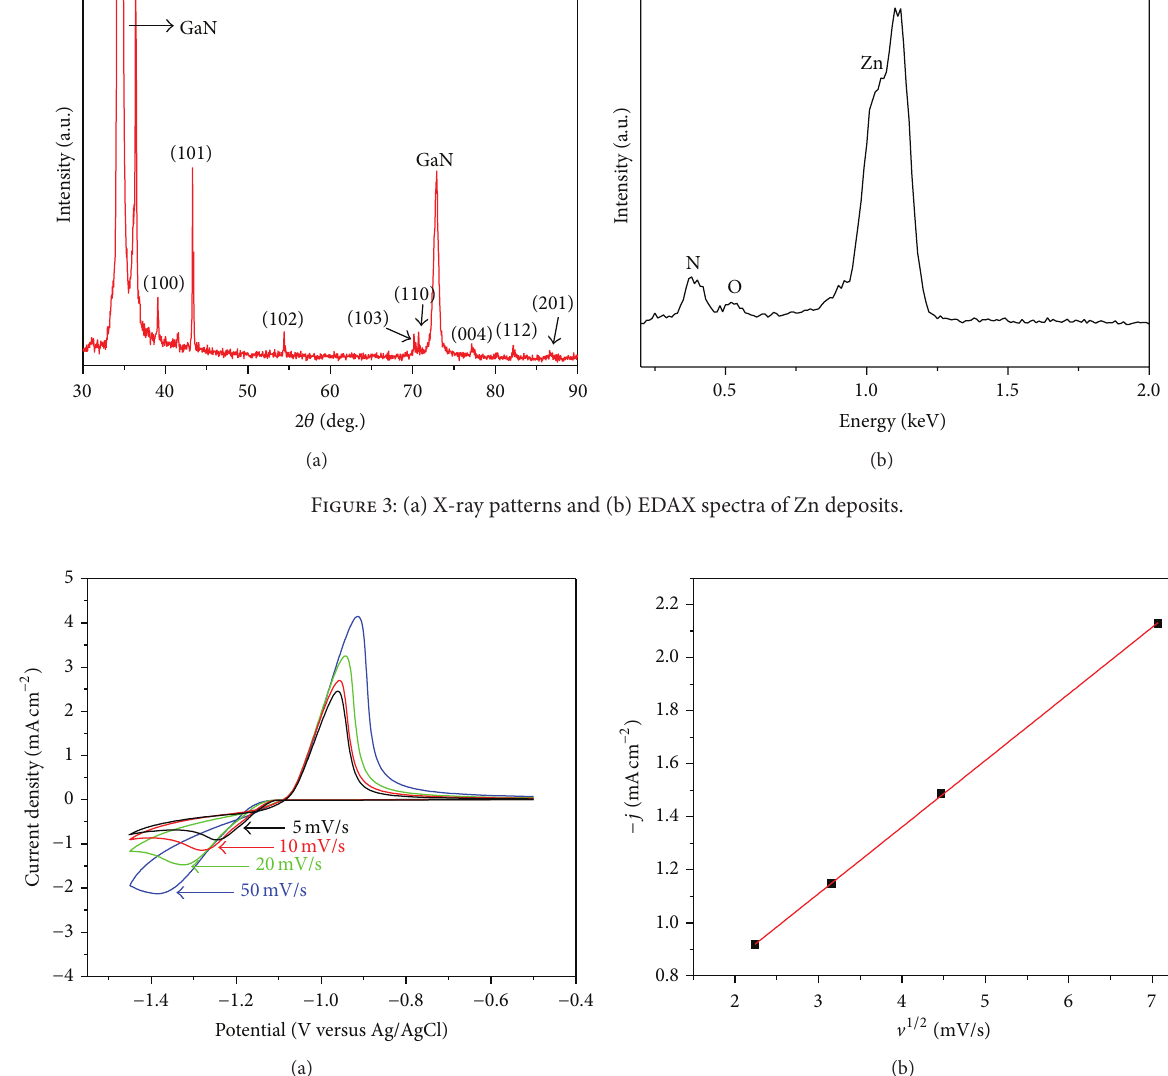
Figure 4: (a) Cyclic voltammograms for Zn deposition on GaN at different scan rates. (b) A fitted line plot for the current density of cathodic peak versus the square root of the scan